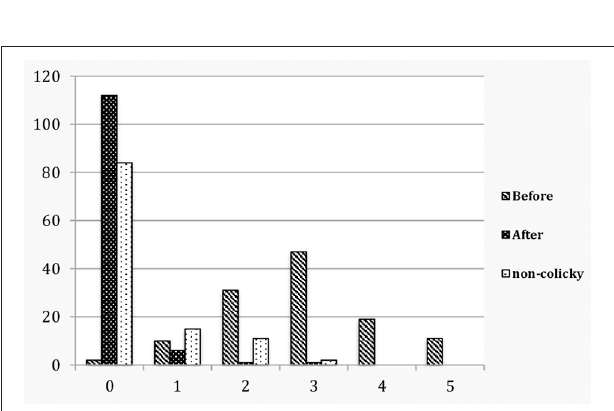
FIGURE 2 | Colicky babies before and after treatment compared to non-colicky babies: total vestibular score.